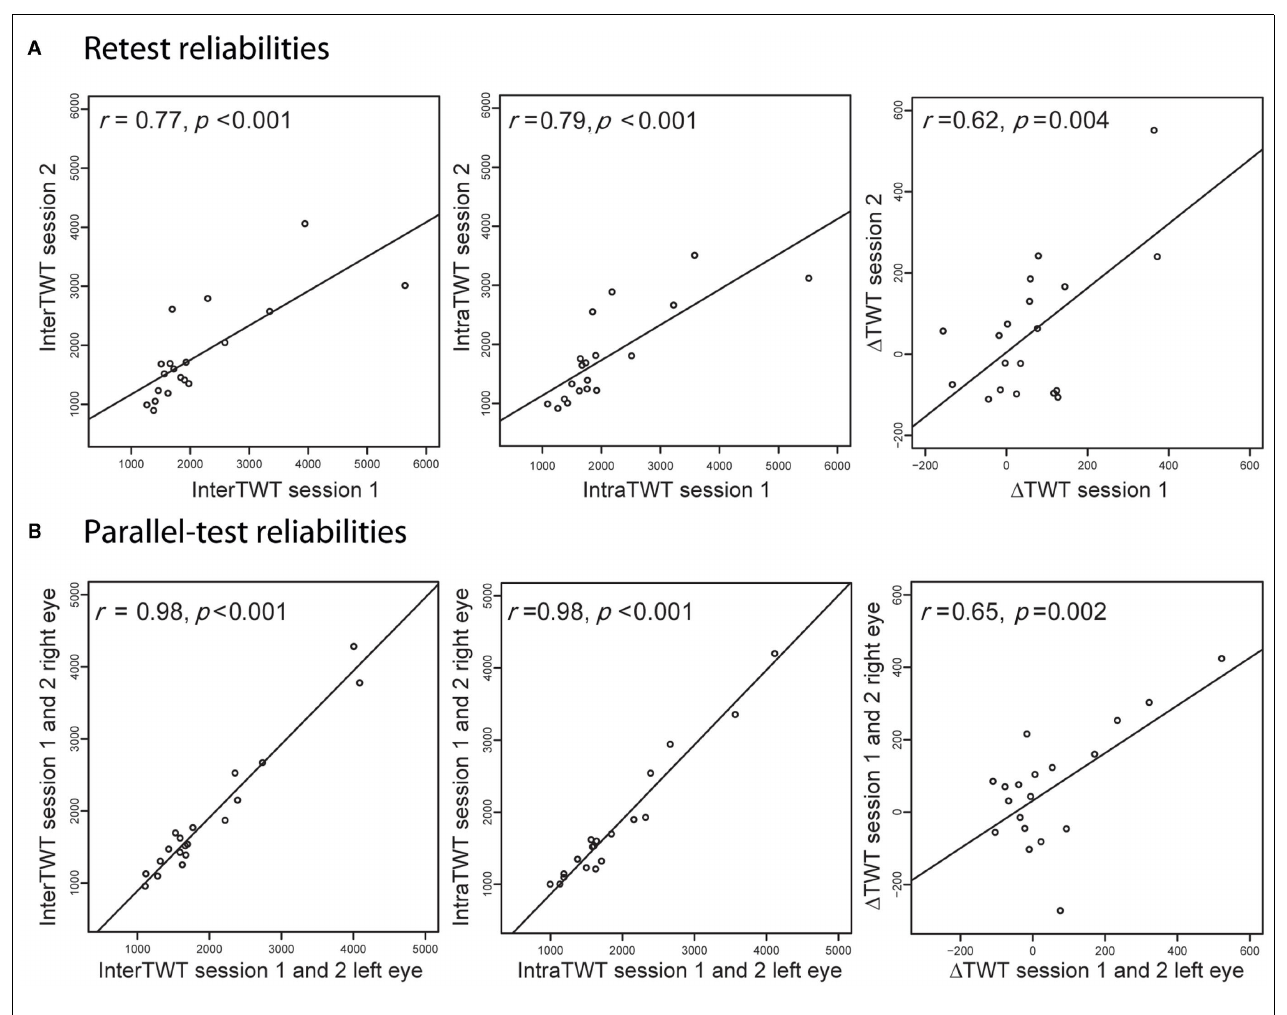
(B) Analyses also show high parallel-test reliabilities for the same psychometric indices, indicating that these psychophysical measures are stable features in humans.